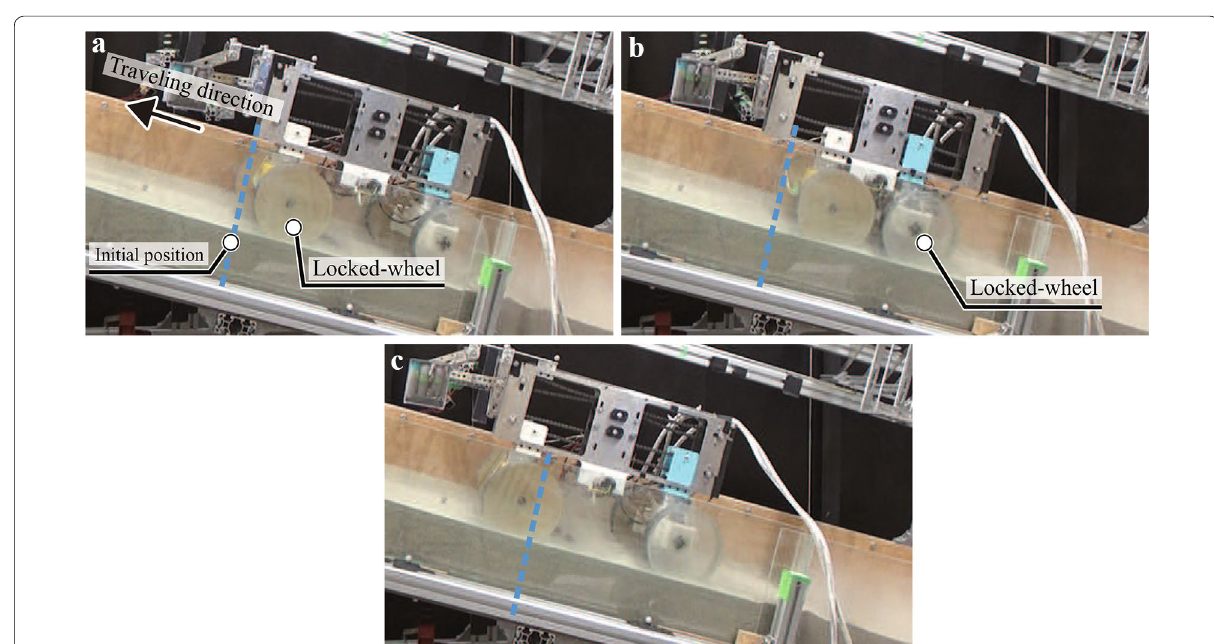
Fig. 2 Actual image of the traveling experiment on the soil. The rover firstly shrinks its wheel-base, and the front wheel is fixed to the ground and supports the rear wheels’ motion ( a – b ). Next, the rover extends its wheel-base, and the rear wheel is also fixed to the ground and supports the front wheels’ motion ( b – c )